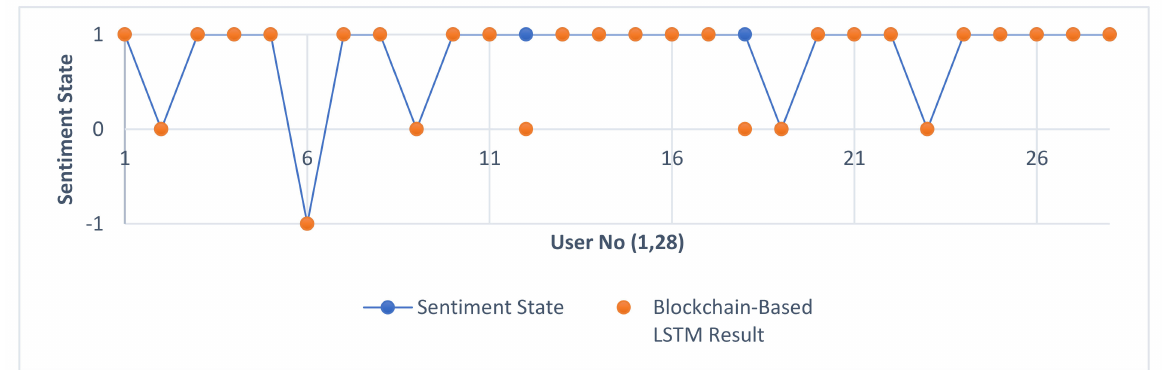
Figure 13. Sentiment state and blockchain-based LSTM comparison.